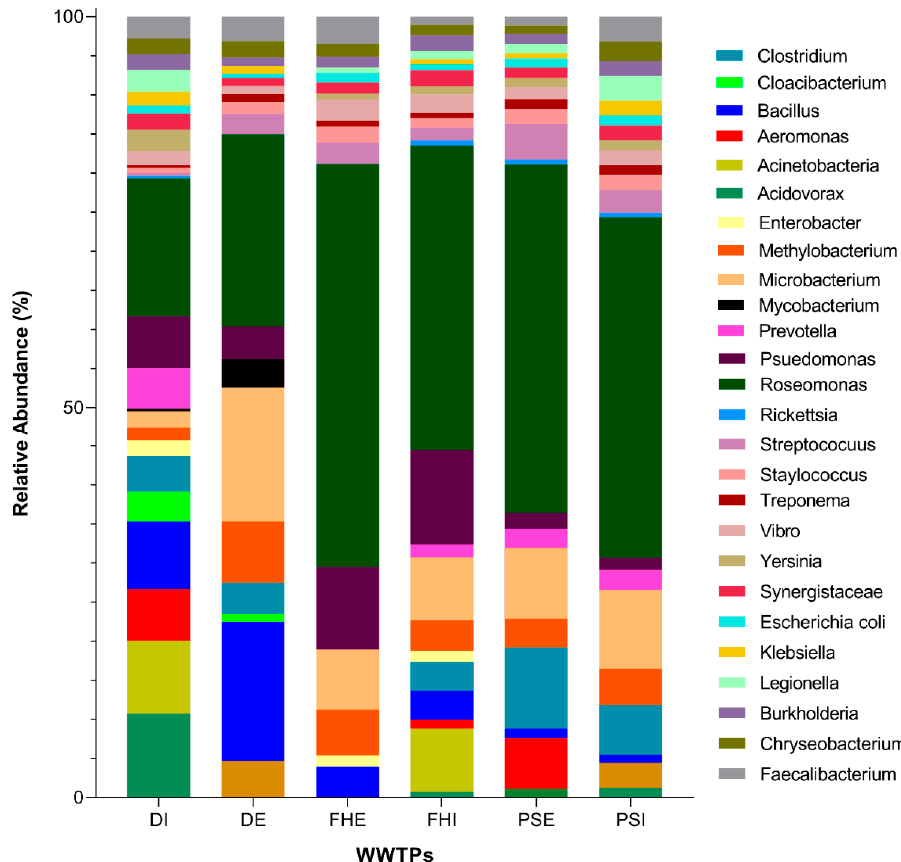
Figure 7. Potential pathogenic bacterial diversity and relative abundance at genus level at the WWTPs.